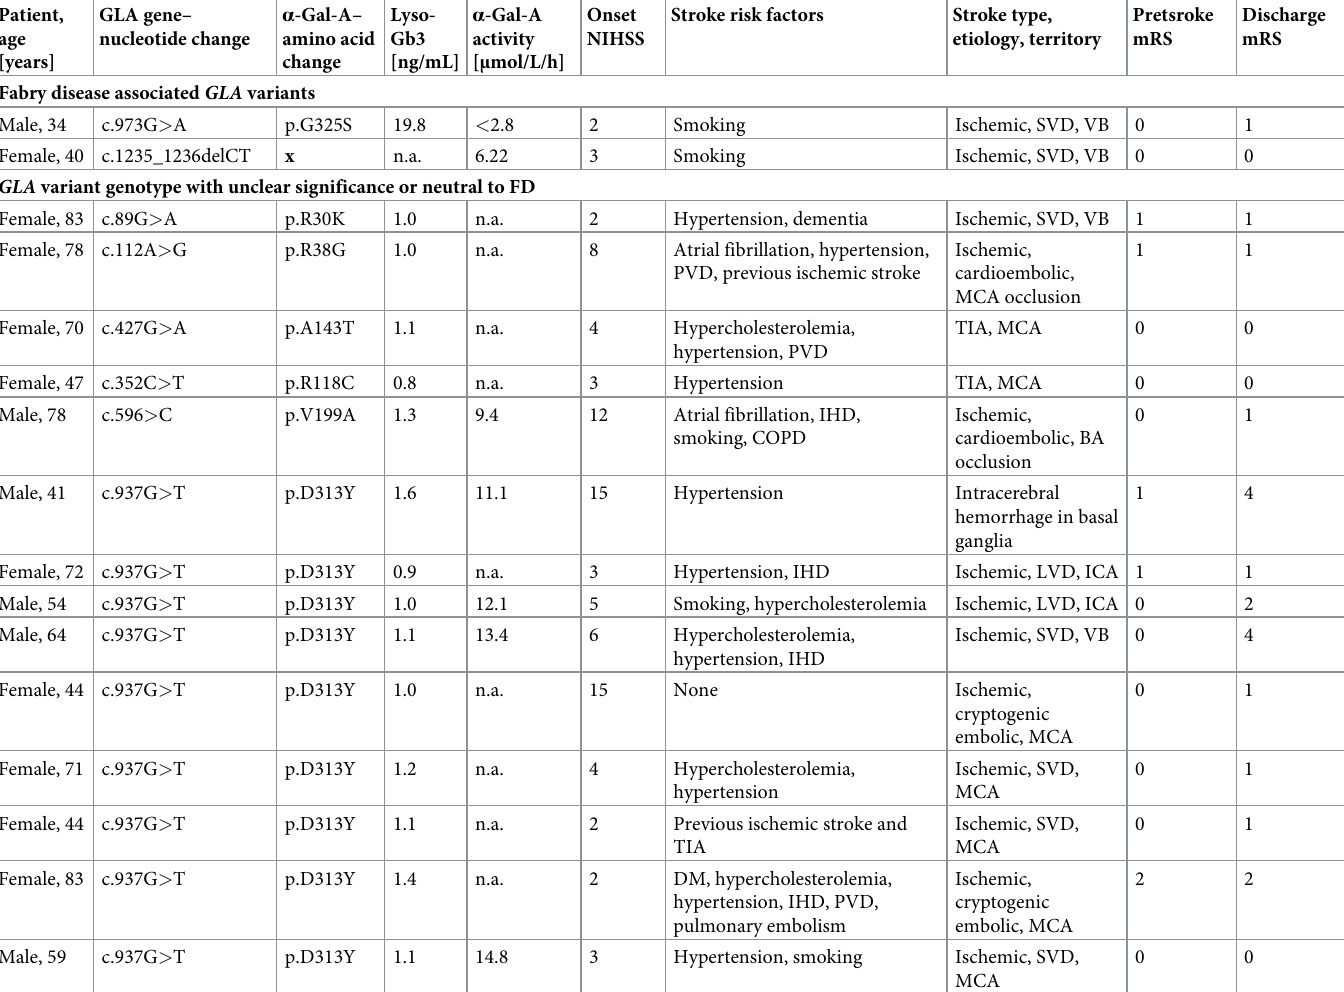
Table 2. Basic characteristics of patients with disease-associated variant or variant genotype in GLA